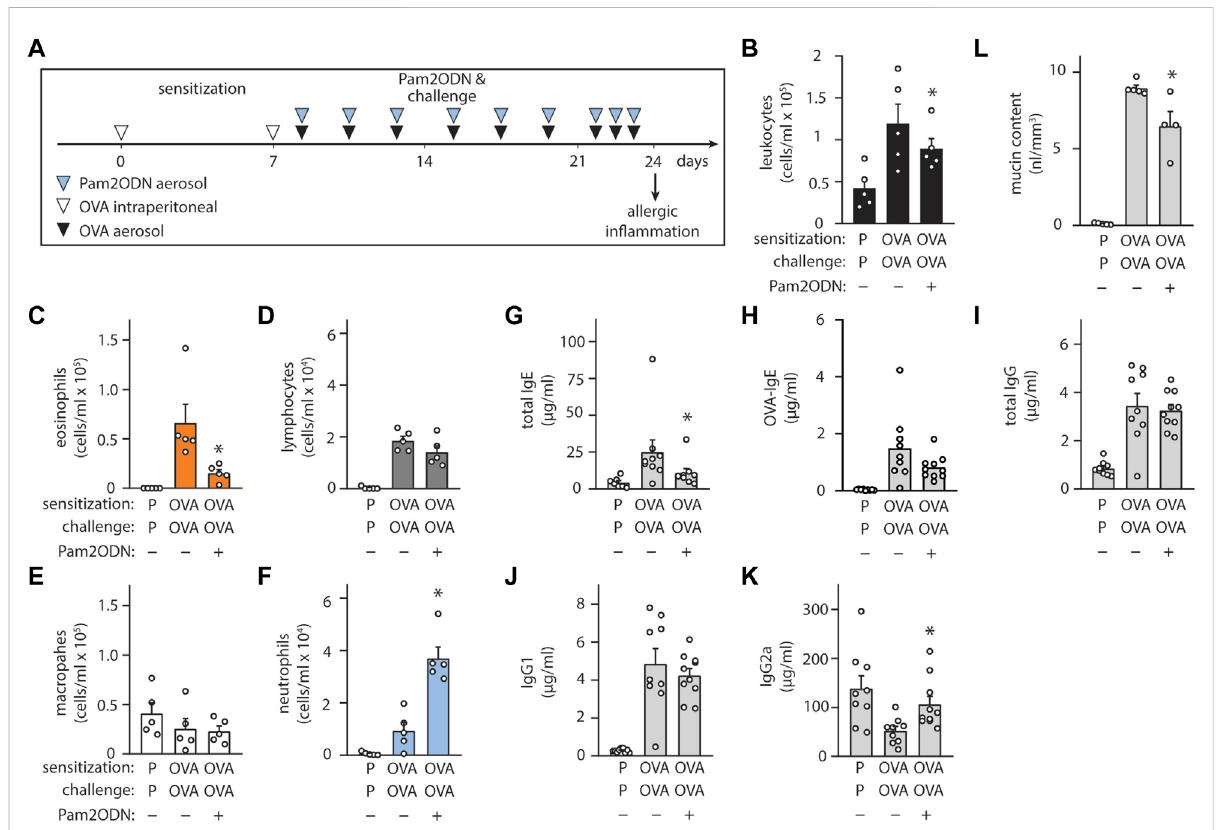
FIGURE 4 Exposure to Pam2-ODN attenuates allergic in fl ammation to OVA. (A) OVA experimental paradigm with sensitization of 20 µg OVA by intraperitoneal injection and aerosol challenges of 2.5% OVA. (B – F) Quanti fi cation of leukocytes in lung lavage for (B) total leukocytes (C) eosinophils, (D) lymphocytes, (E) macrophages, and (F) neutrophils (N = 4-5 mice). (G – J) Quanti fi cation of serum immunoglobulin concentrations by ELISA for (G) IgE, (H) OVA-speci fi c IgE, (I) IgG, (J) IgG1, and (K) IgG2a (N = 8-9 mice). (L) Quanti fi cation of intracellular mucin content by image analysis of airway stained with PAFS (N = 4-5 mice). Bars show mean +/- SEM. p * < 0.05 by unpaired students ’ t test for OVA vs. OP-OVA. P = PBS. OVA =